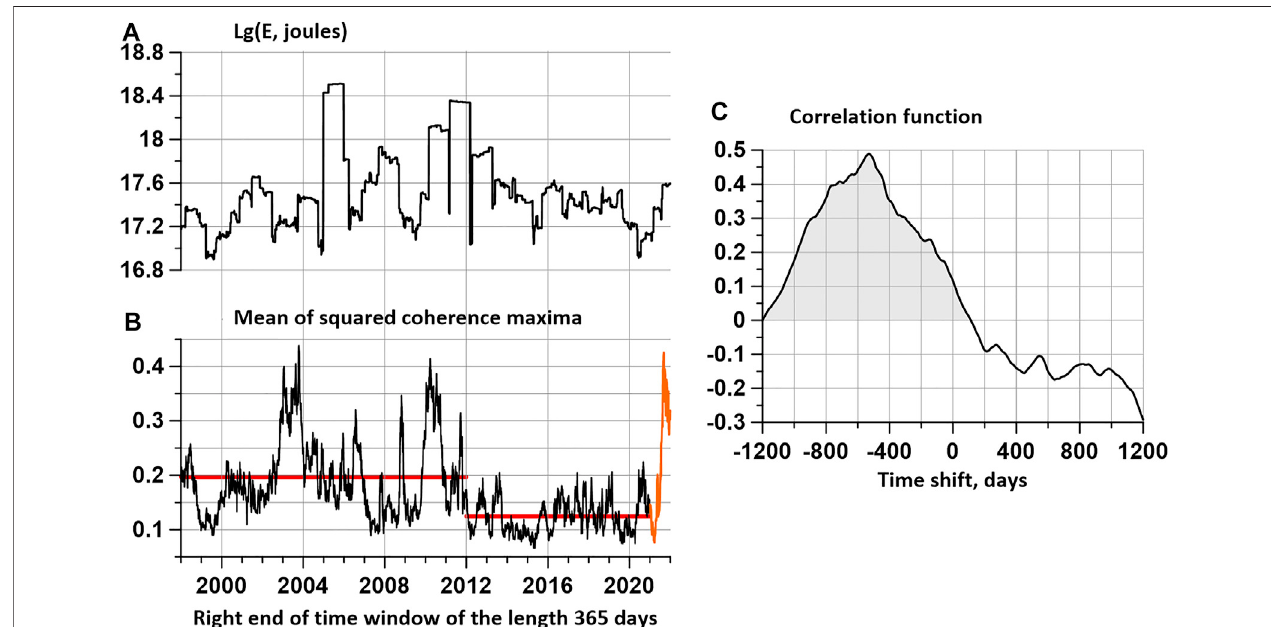
FIGURE 8 | (A) — plot of the values of the decimal logarithm of the released seismic energy (joules) in a sliding time window 365 days long with a shift of 3 days; (B) — the black line represents the average of the quadratic coherence maxima between the LOD and the fi rst principal component of the 3 seismic noise properties in a 365-day window with a 3-day offset for the positions of the right end of the time window in the interval 1998 – 2021, the red horizontal lines represent the average coherencevaluesfortimeintervals1998 – 2012and2012 – 2021.TheorangelineinFigure (B) representstheplotofthemeancoherenceforthepositionsoftheright endofthetimewindowintheinterval2021 – 2022.TheplotinFigure (C) representsthecorrelationfunctionbetweenthelogarithmofthereleased seismicenergyandthe meanquadraticcoherencefortimeshiftsof±1200days.Astrongshiftofthecorrelationfunctionplottowardsnegativetimeshiftswithamaximumforashiftof-530 days con fi rms the hypothesis that bursts of coherence between LOD and seismic noise properties precede seismic energy releases with a delay of about 1.5 years.